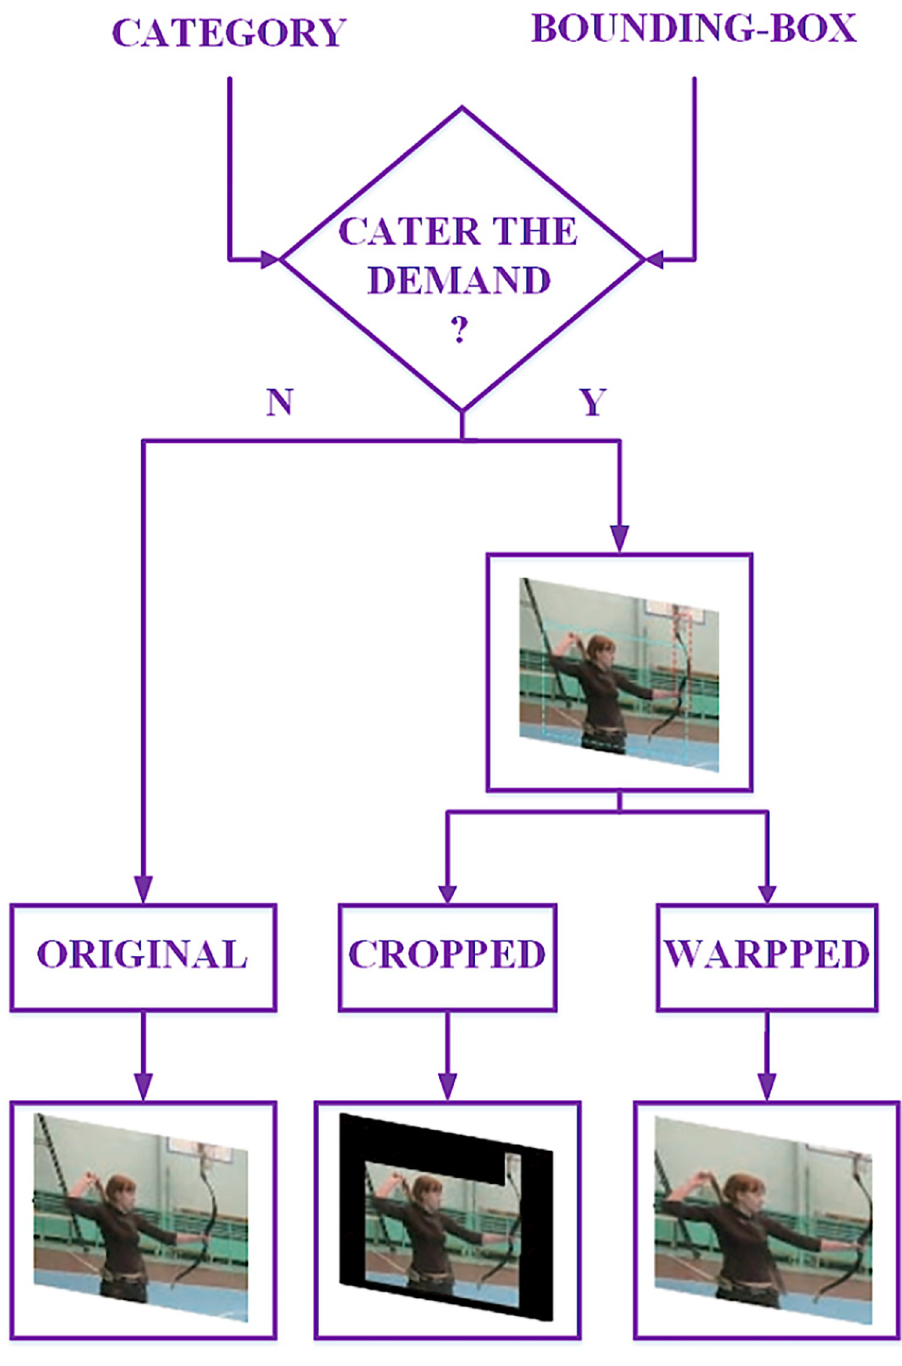
Fig 6. The image transformation